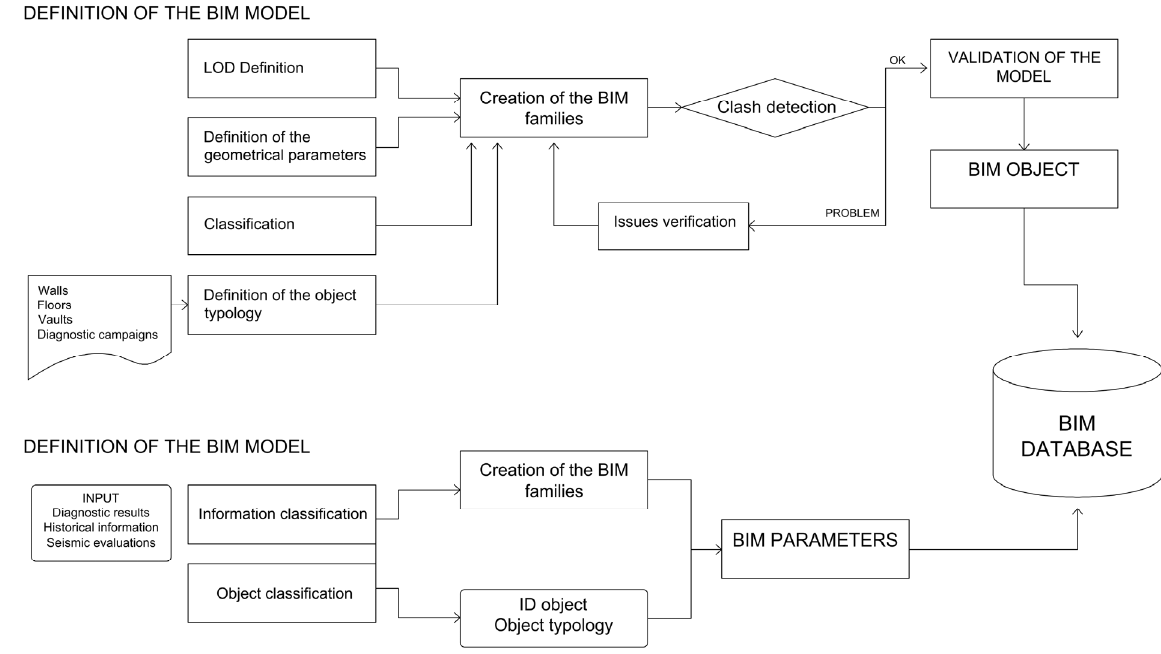
Figure 1. Flowchart of the research.